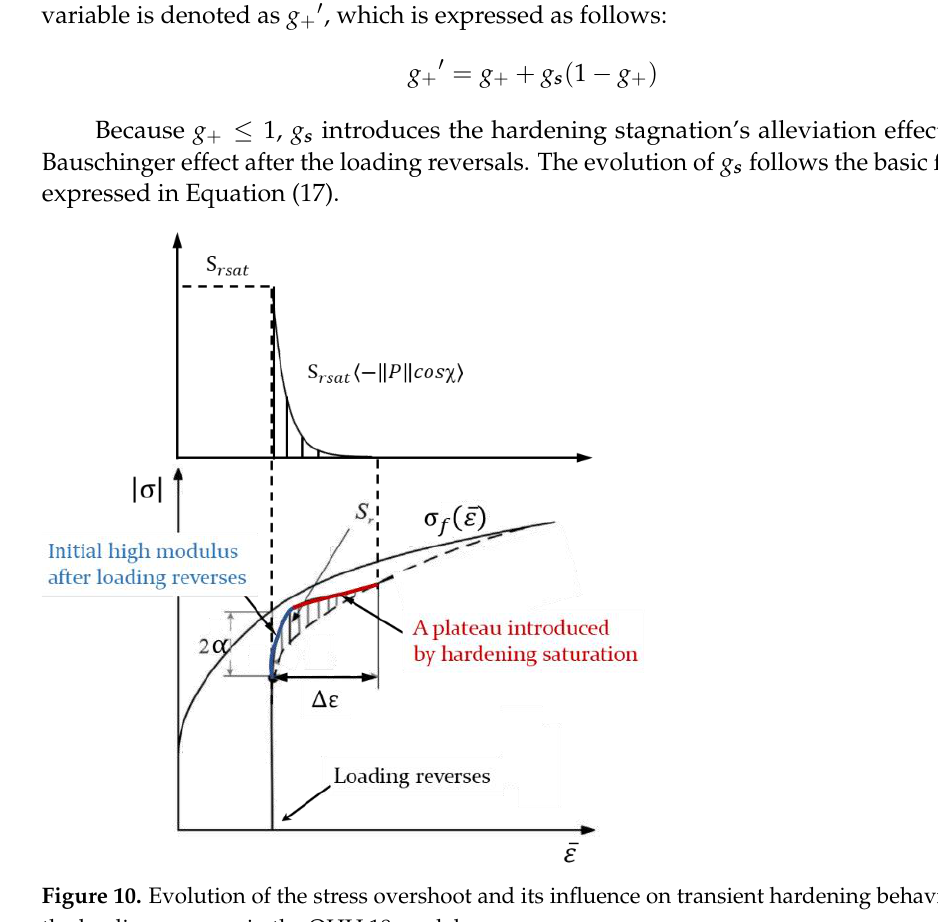
Figure 10. Evolution of the stress overshoot and its influence on transient hardening behaviors after the loading reverses in the QHH 18 model.